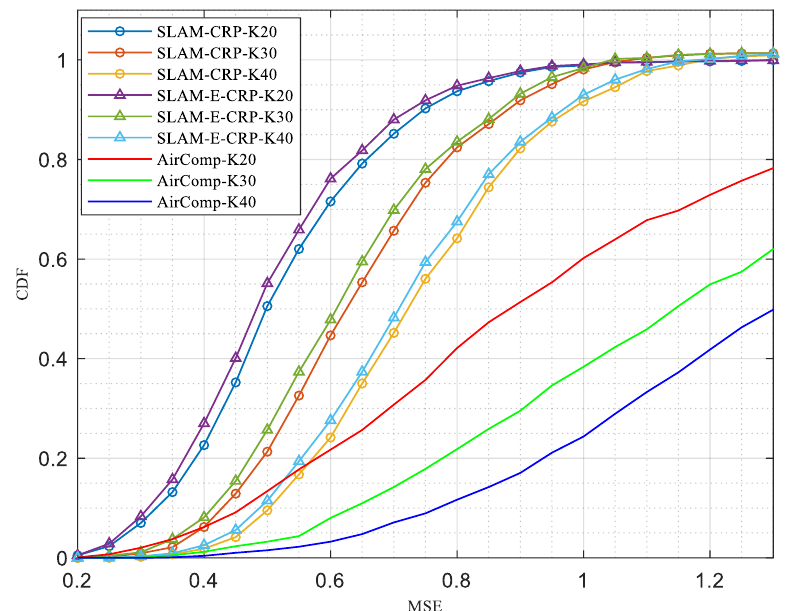
Figure 10. Cumulative distribution of MSE ( 𝛼 = 0.5 ).